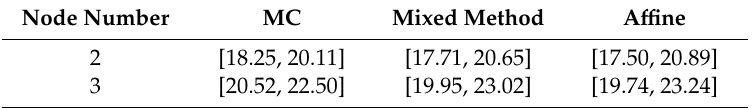
Table 4. Voltage angle intervals.